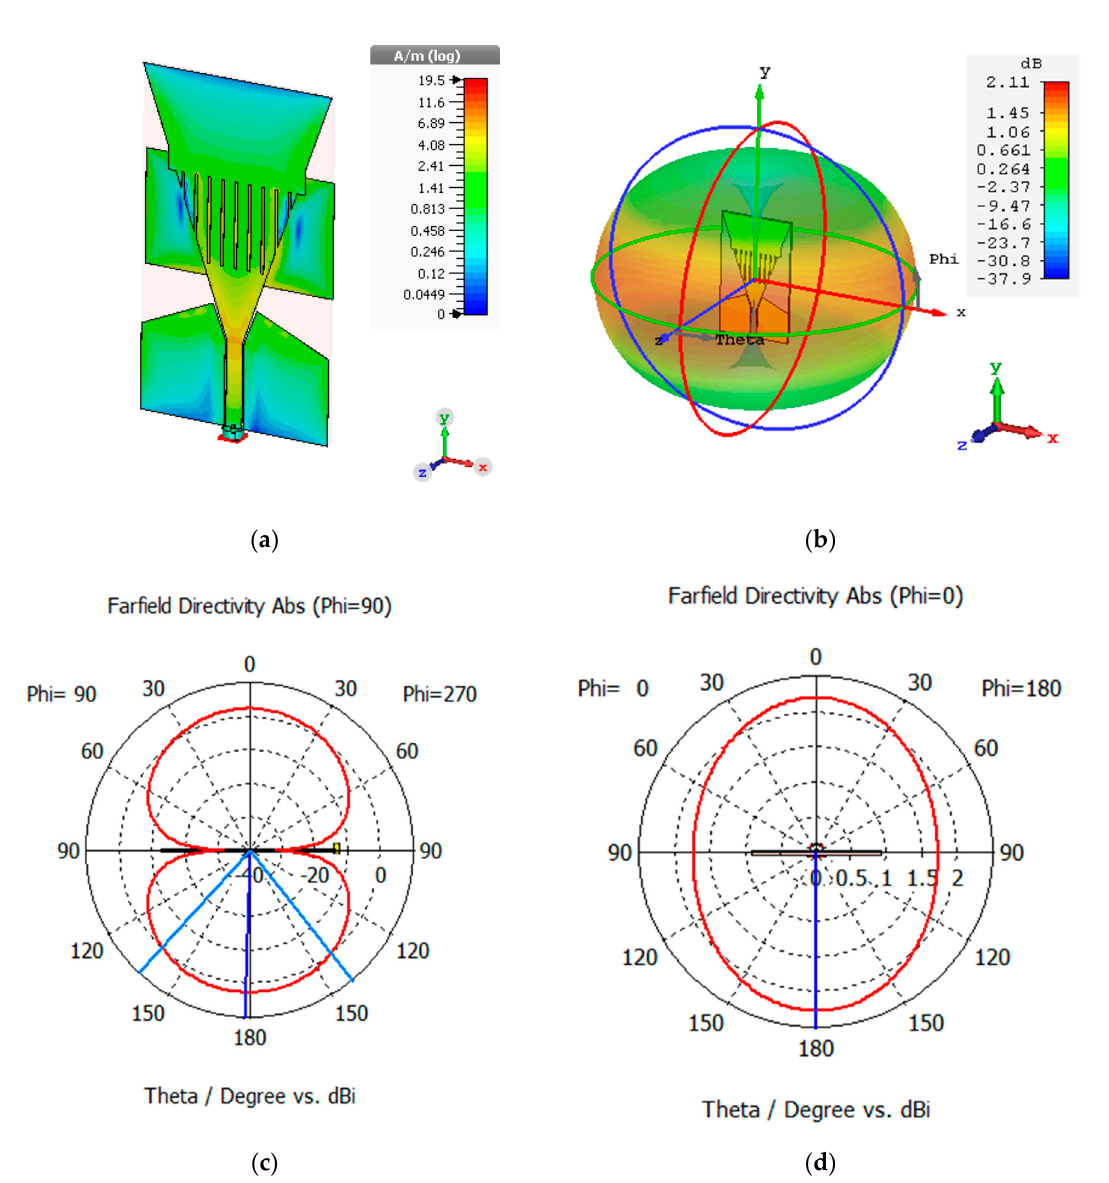
Figure 13. Optimal 35 mm antenna ( a ) surface current ( b )3D farfield radiation pattern ( c ) E-Plane radiation pattern ( d ) H-Plane radiation.